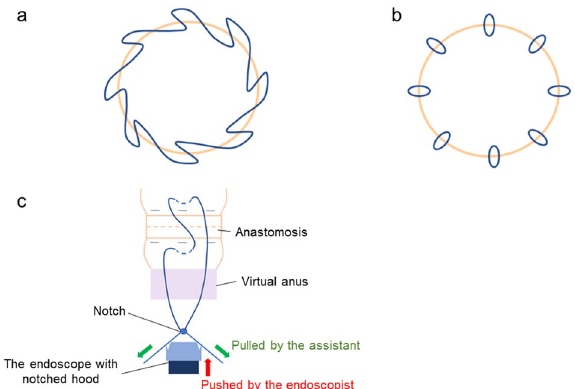
Figure 2. Schemas of endoscopic hand suturing for rectal anastomosis. ( a ) The continuous suturing with a barbed suture. The anastomosis was sutured circumferentially. ( b ) The nodule-suturing method. ( c ) In the nodule suturing, the slipknot is created outside the tract after retrieving the needle. The knot is delivered to the lumen by using the tip of the endoscope with the notched hood (red direction) while the thread remains tensioned by the assistant (green direction).